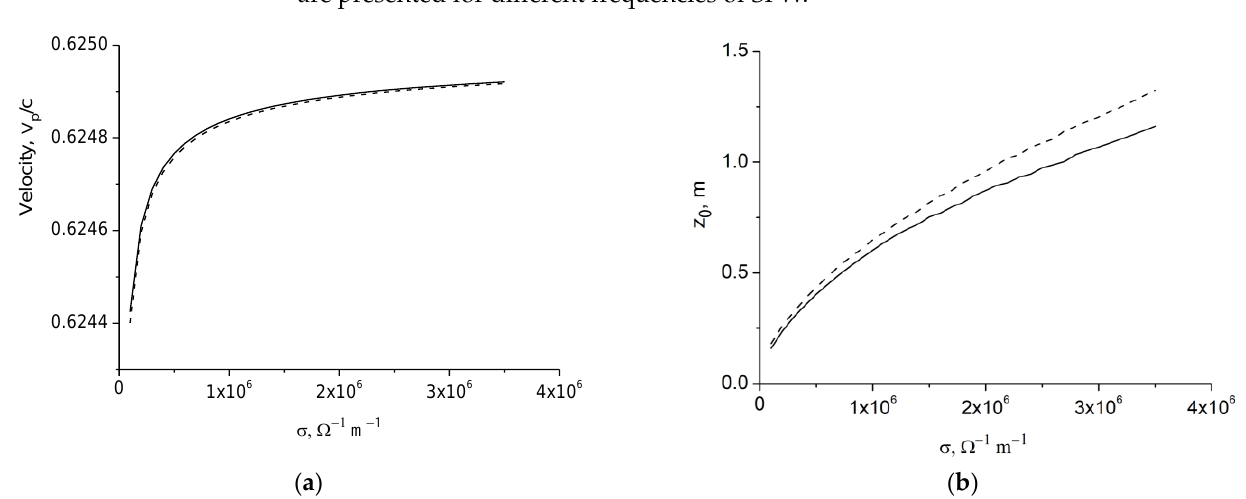
Figure 6. The attenuation length as a function of conductivity. 𝑟 0 = 10 μm, 𝜔 = 10 THz , 1 − air; 2 − coated metal wire.